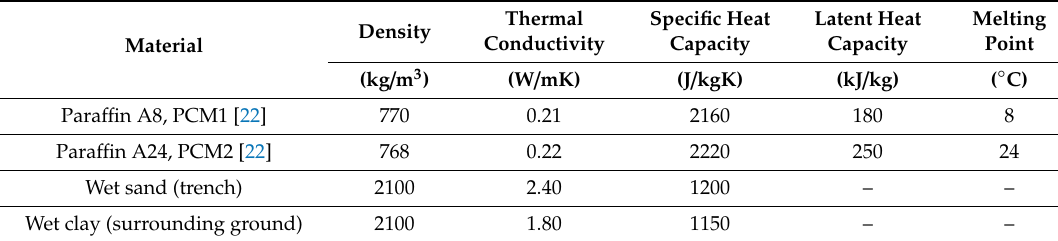
Table 1. Physical properties of backfill materials (within trench) and surrounding ground. PCM = phase change